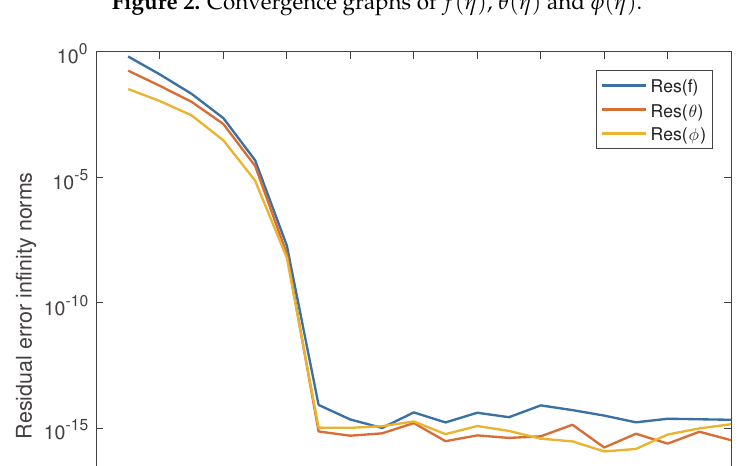
Figure 2. Convergence graphs of f ( η ) , θ ( η ) and φ ( η ) .